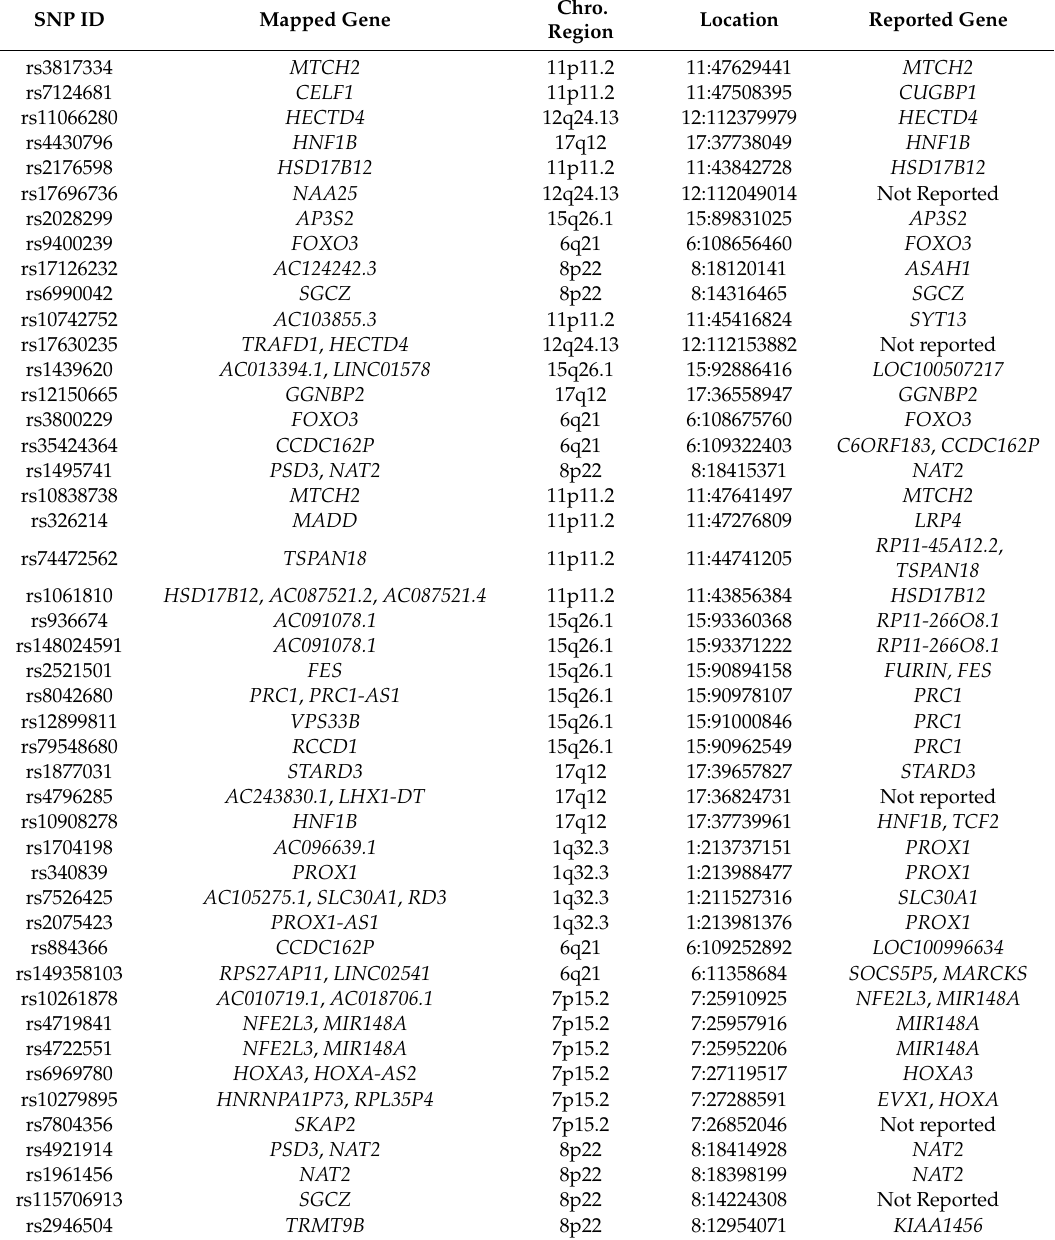
Table 2. List of the 46 SNPs located in the identified eight shared chromosomal regions and their reported a ff ected genes. Data extracted from the NHGRI-EBI GWAS